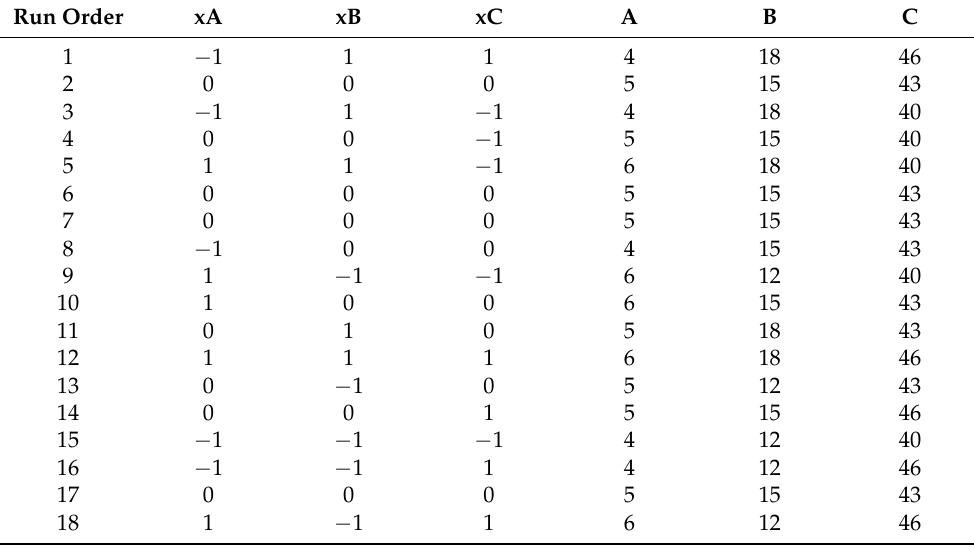
Table 1. Face-centered design with coded and natural